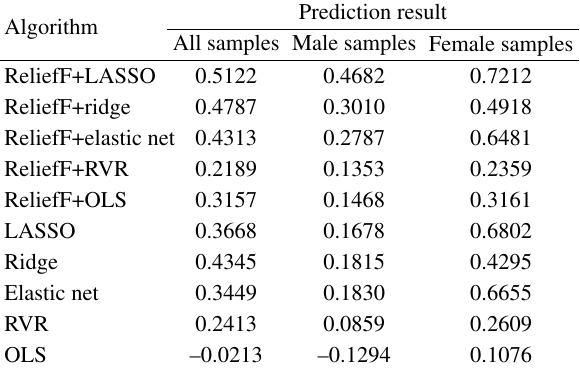
Table 2 Prediction results of five regression models (regression coefficients) from proposed framework [22]